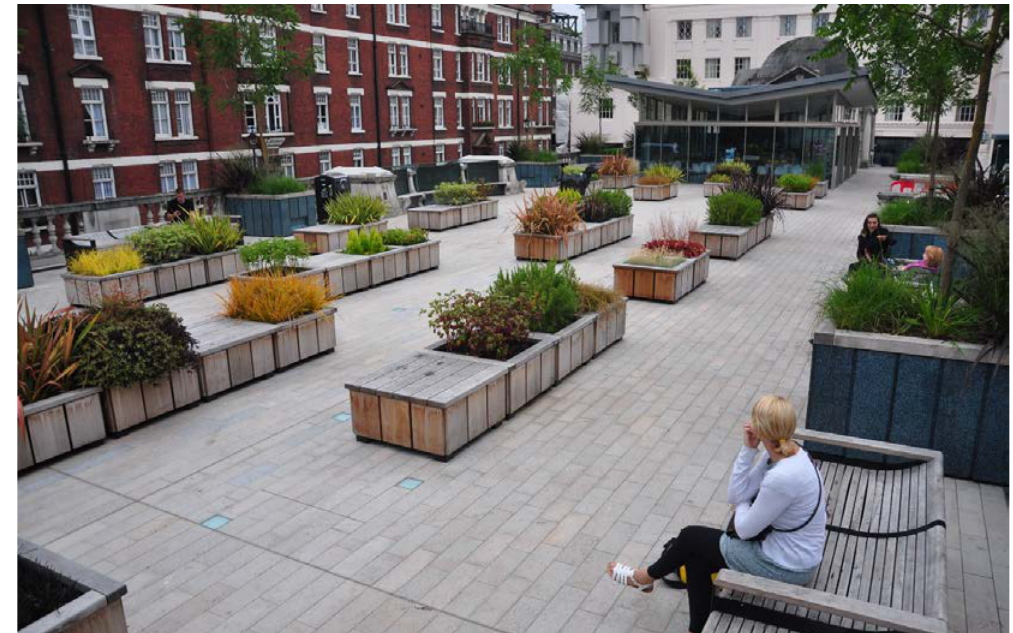
Figure 9. Brown Hart Gardens in 2014 (Andy Thornley